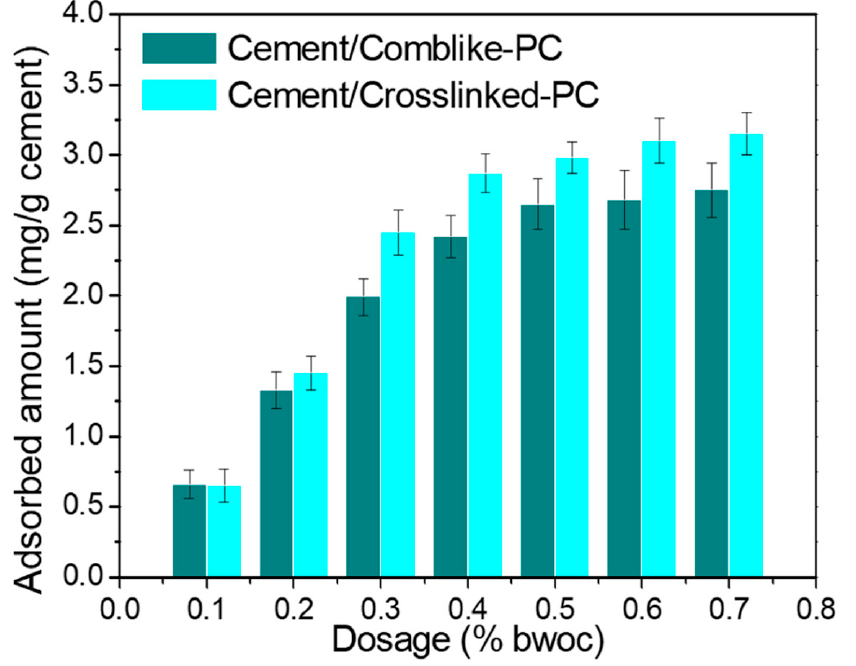
Figure 6. Absorbed amounts comb-like-PC and crosslinked-PC in cement paste at various dosage (% bwoc).